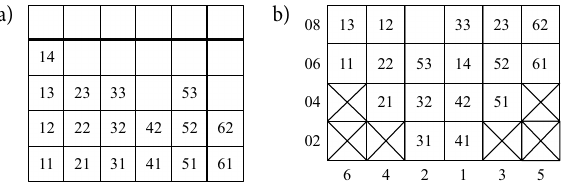
Fig. 6. The yard plan and stowage plan of a bay: a – the yard plan of a bay; b – corresponding stowage plan of the bay